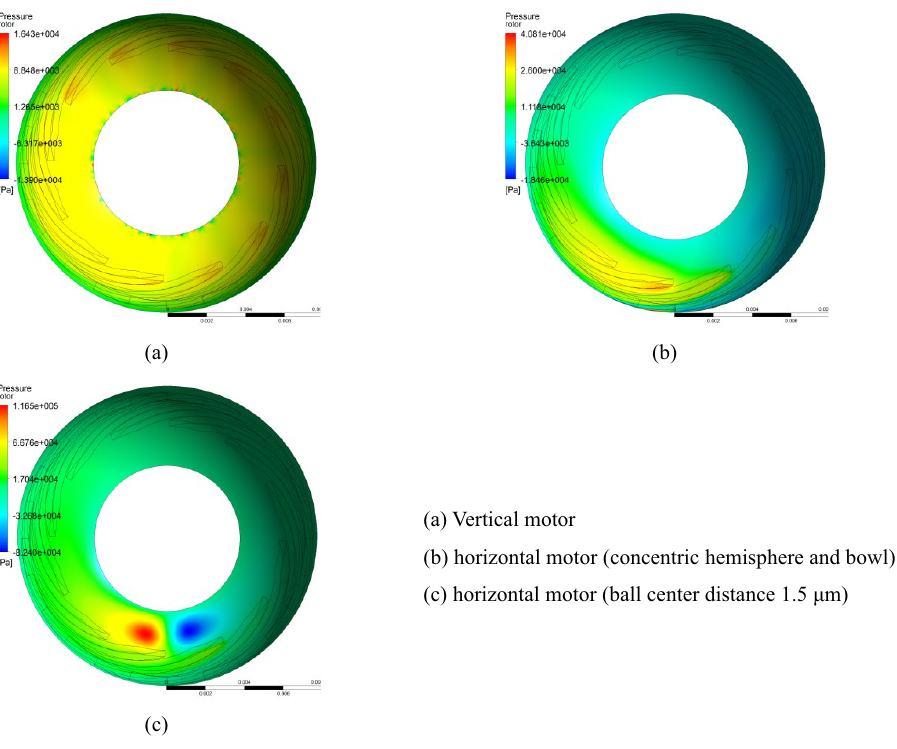
Figure 11. Pressure distribution of gas film under critical contact